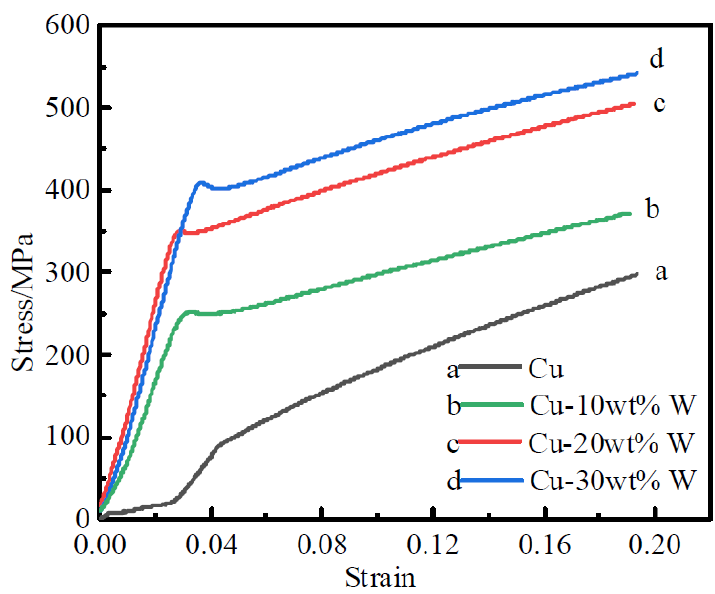
Figure 7. Room temperature compression stress – strain curves with increasing W content.